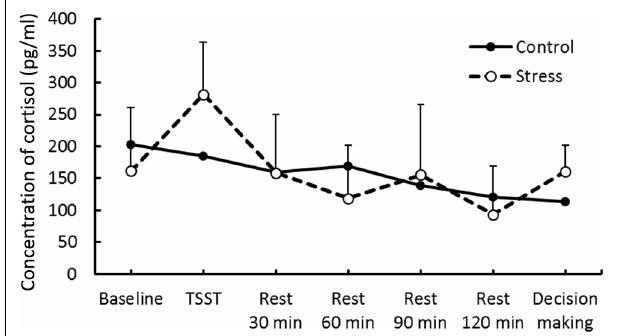
FIGURE 3 | Cortisol concentration in each group. Error bars indicate standard errors of